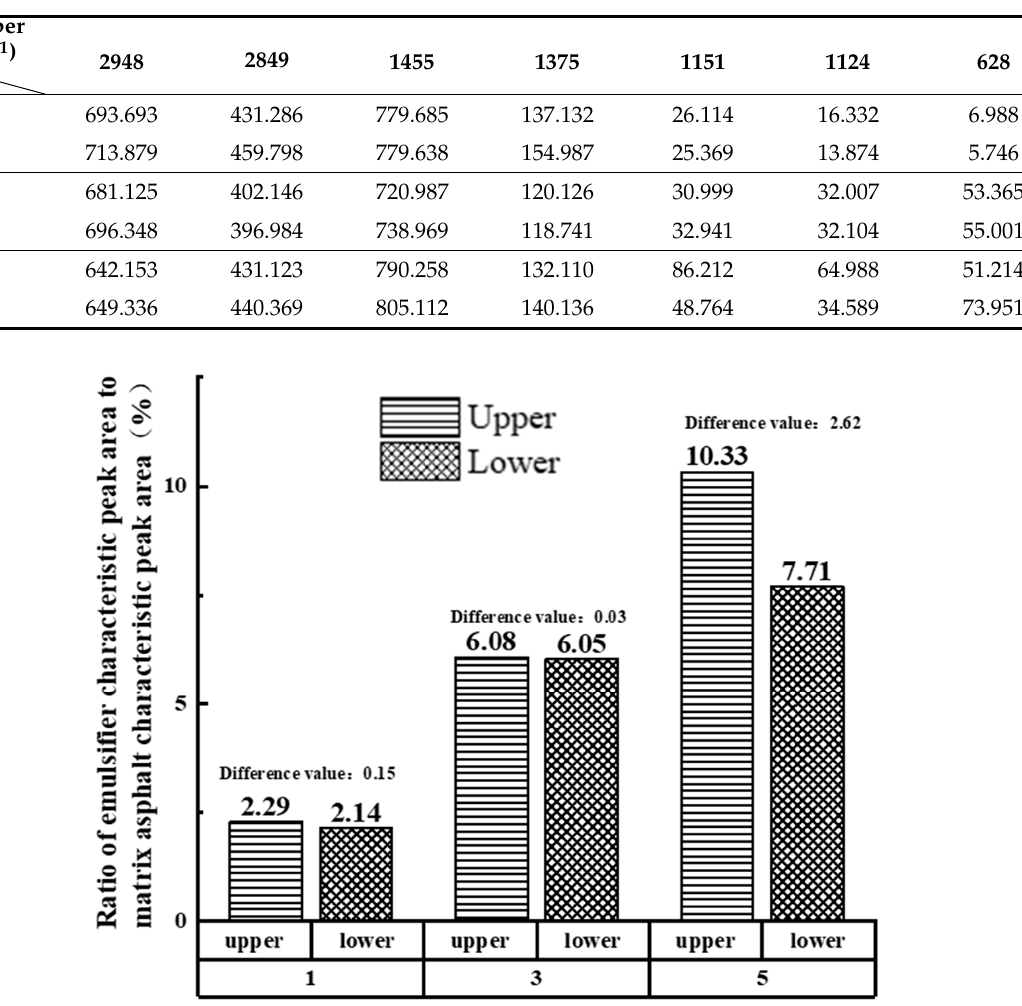
Table 6. Infrared characteristic peak area of evaporation residue of bio-oil asphalt/water emulsion with different emulsifier contents.